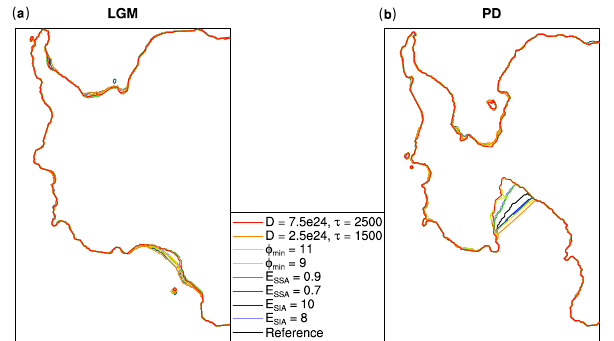
Figure 10. Grounding-line positions at (a) the LGM, 16ka and (b) the PD, for the reference simulation and for simulations with varia- tions of the indicated